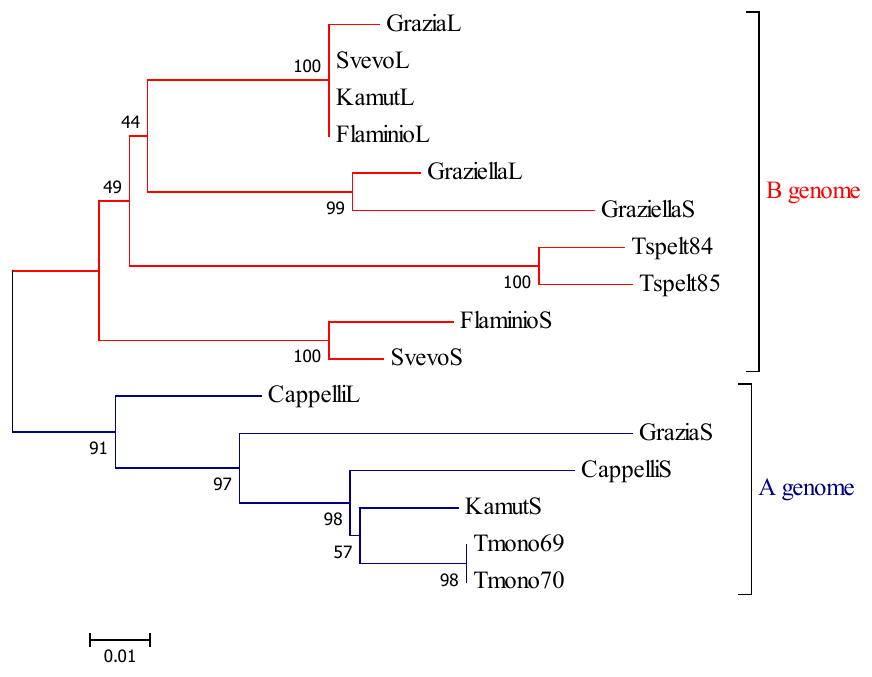
Figure 6. Neighbor-Joining tree of α -gliadin deduced amino acid sequences. The optimal tree with the sum of branch length = 0.533 is shown. The percentage of replicate trees in which the associated taxa clustered together in the bootstrap test (1,000 replicates) are shown next to the branches. The evolutionary distances were computed using the Poisson correction method and are in the units of the number of amino acid substitutions per site. All positions containing gaps and missing data were eliminated from the dataset (Complete deletion option). L and S refer to long and short deduced amino acid sequences; Tspelt: Triticum speltoides ; Tmono: Triticum monococcum